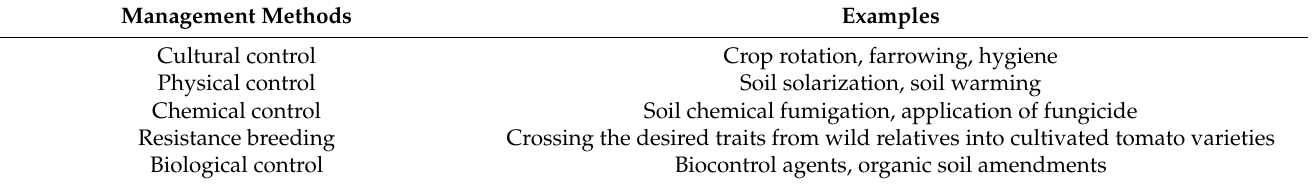
Table 1. Different management methods and their examples are mentioned in this review.